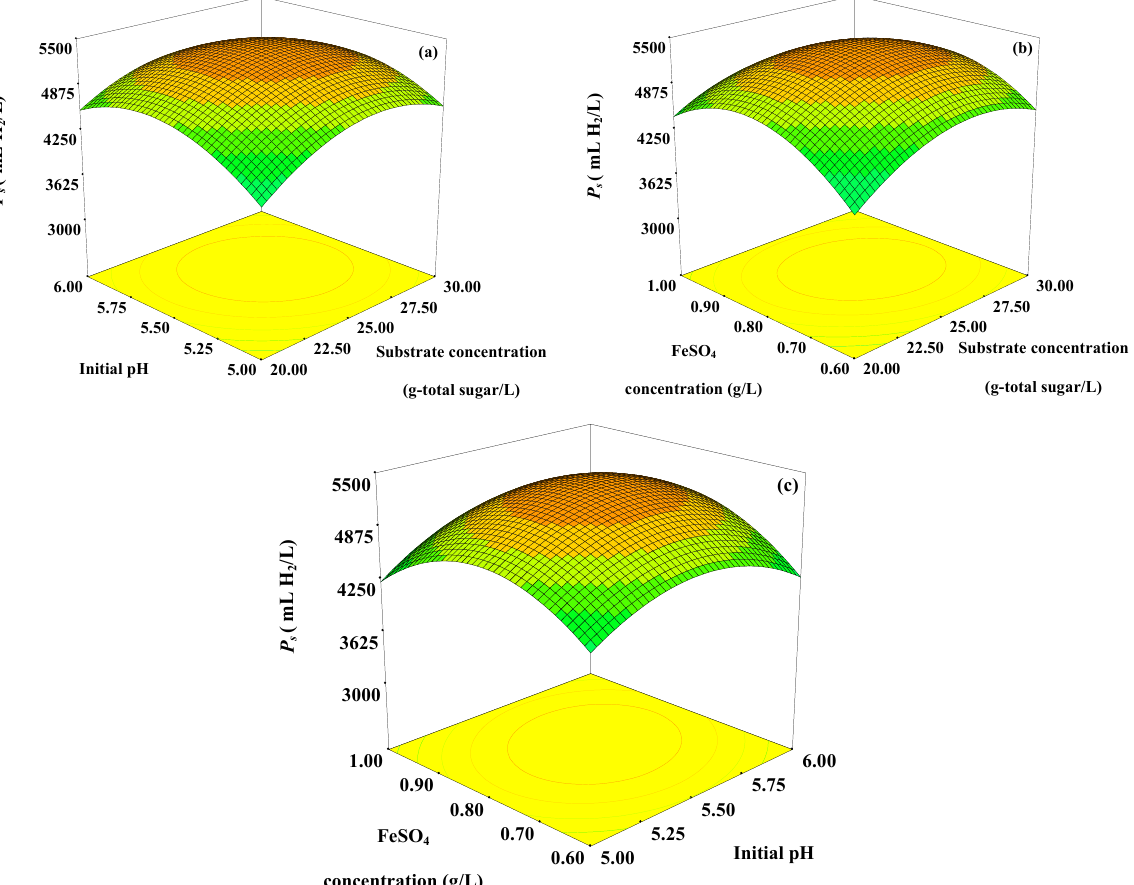
Figure 1. Response surface plots showing ( a ) the effects of initial pH, substrate concentration, and their mutual interaction on P with optimum level of FeSO concentration s 4 (0.78 g/L); ( b ) the effects of FeSO concentration, substrate concentration and their mutual 4 interaction on P with optimum level of initial pH (5.56); and ( c ) the effects of FeSO s 4 with optimum level of substrate concentration, initial pH and their mutual interaction on P s concentration (25 g-total